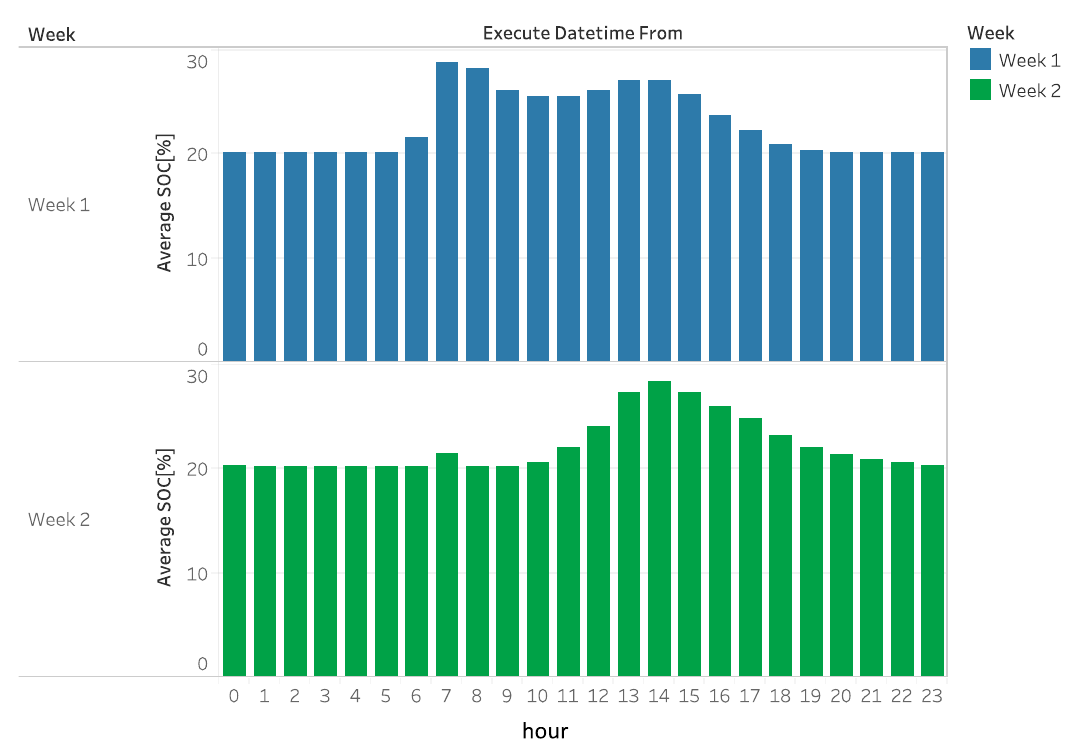
Figure 8. Comparison of average SOC of week 1 and week 2.